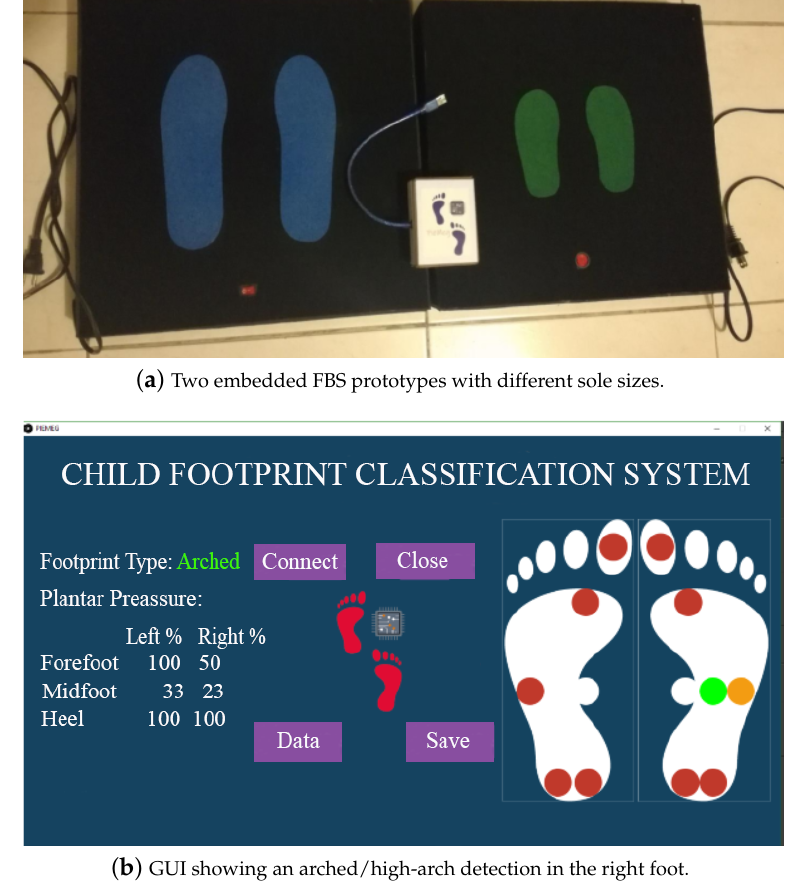
Figure 7. Hardware and software prototype used for the data collection stage. ( a ) The embedded sensor testbed with hardware coupling; ( b ) visualization and analysis of the plantar pressure points on the graphical